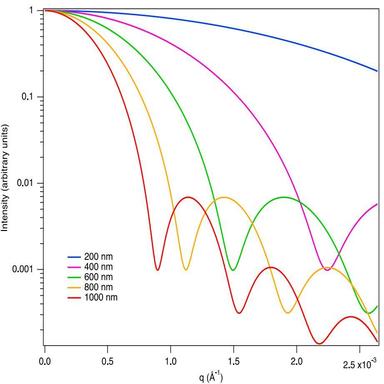
Shows the effect of increasing particle diameter on scattering for spherical particles. Data is calculated using eqs. and 10, using a Gaussian particle size distribution with a polydispersity of 5 % (λ = 633 nm, n = 1.33). The positions of the minima are very accurate determinants of particle size. The chosen q range is typical for a light scattering experiment. Data generated using an in-house program written in MATLAB.